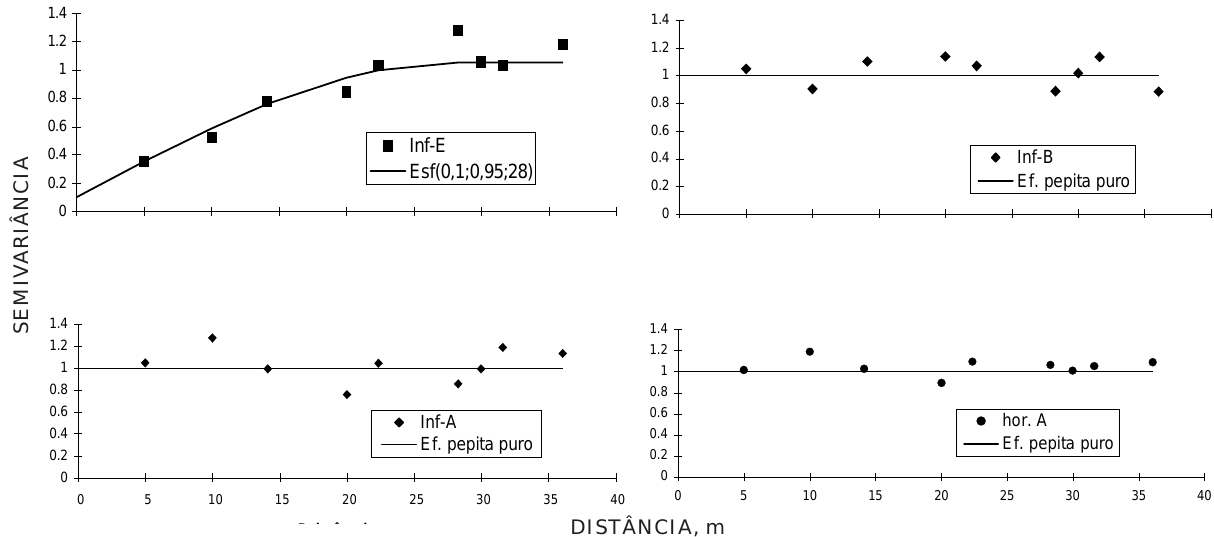
Figura 4. Semivariogramas escalonados da infiltração de água nos horizontes A, E e Bt e da espessura do horizonte A, sob pastagem.